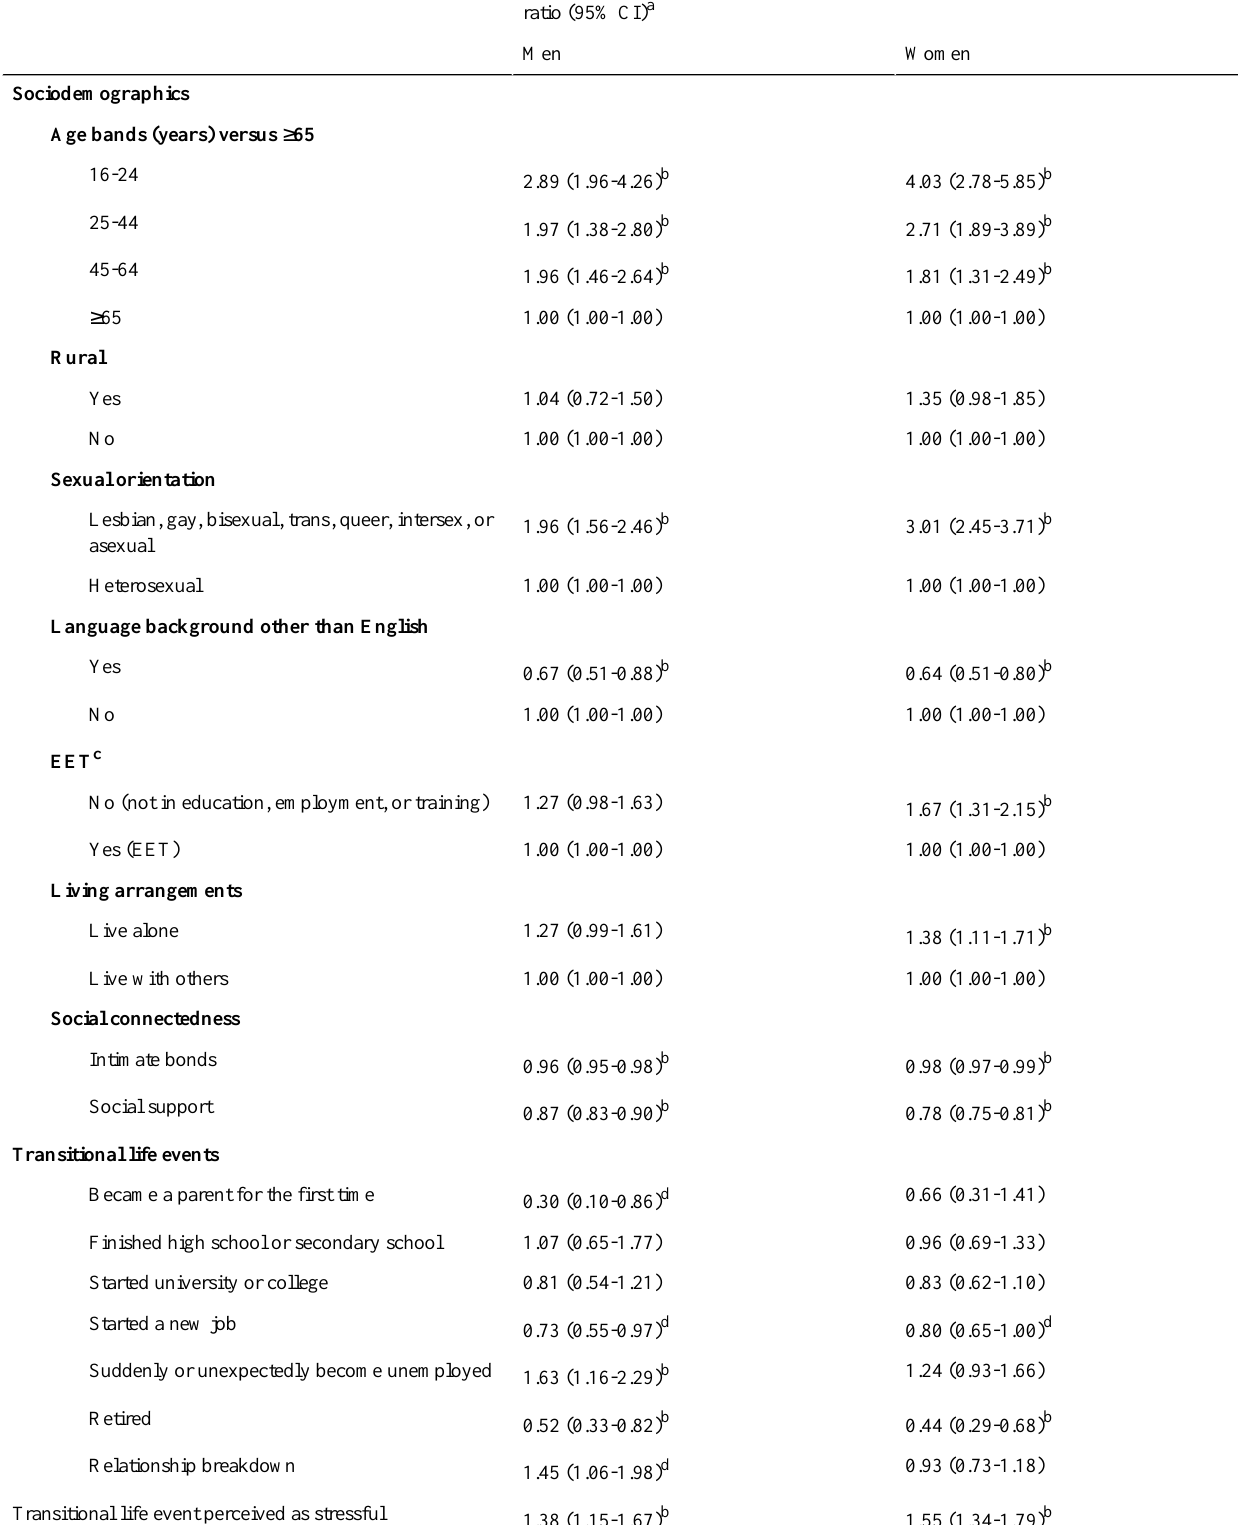
Table 3. Adjusted odds ratios for men’s and women’s self-reported suicidal thoughts and behaviors by sociodemographic variables, including social connections and transitional life events (men, n=2667 and women,